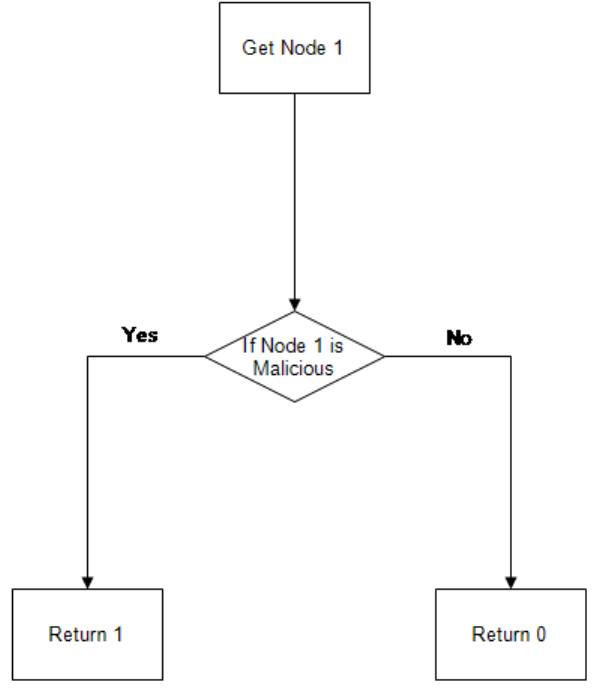
Figure 4. Algorithm to check malicious nodes .